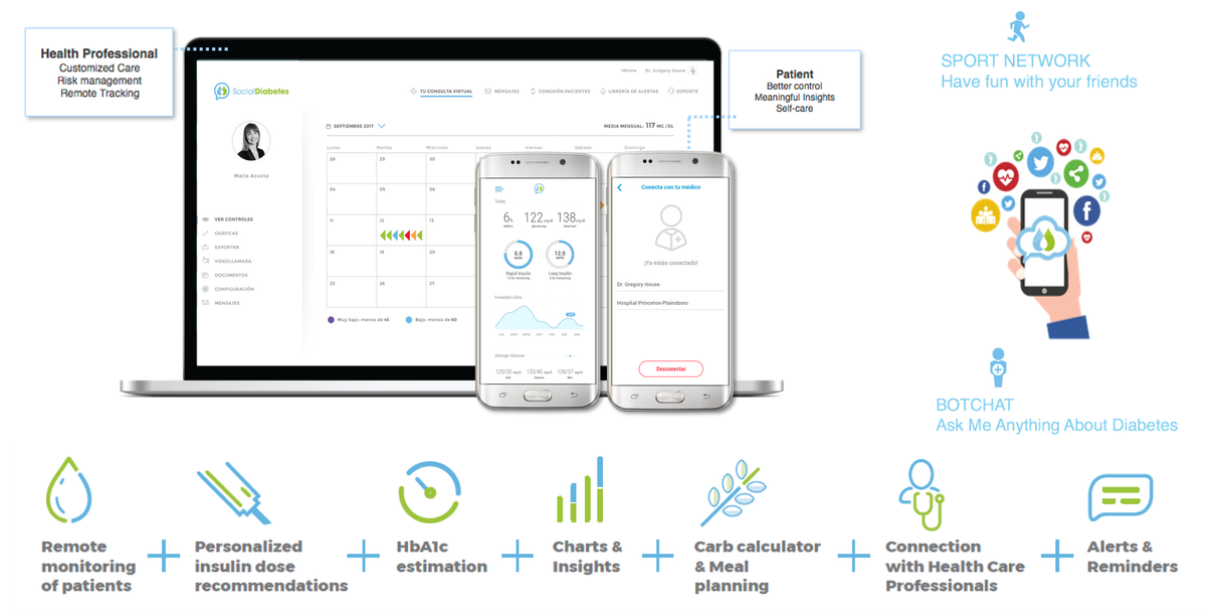
Figure 1. General scheme of the SocialDiabetes integrated